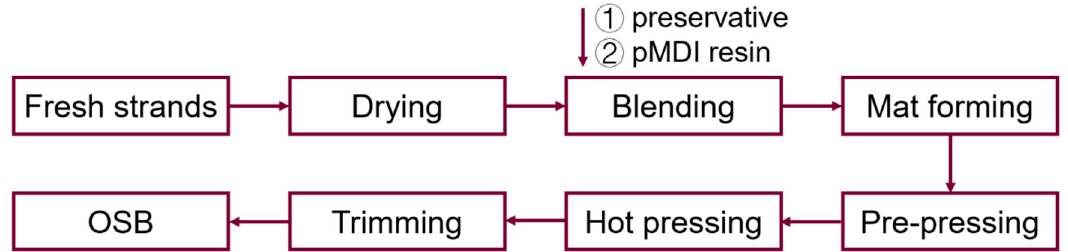
Figure 2. Flow chart of β CD–B-complex-treated Oriented Strand Board manufacturing.